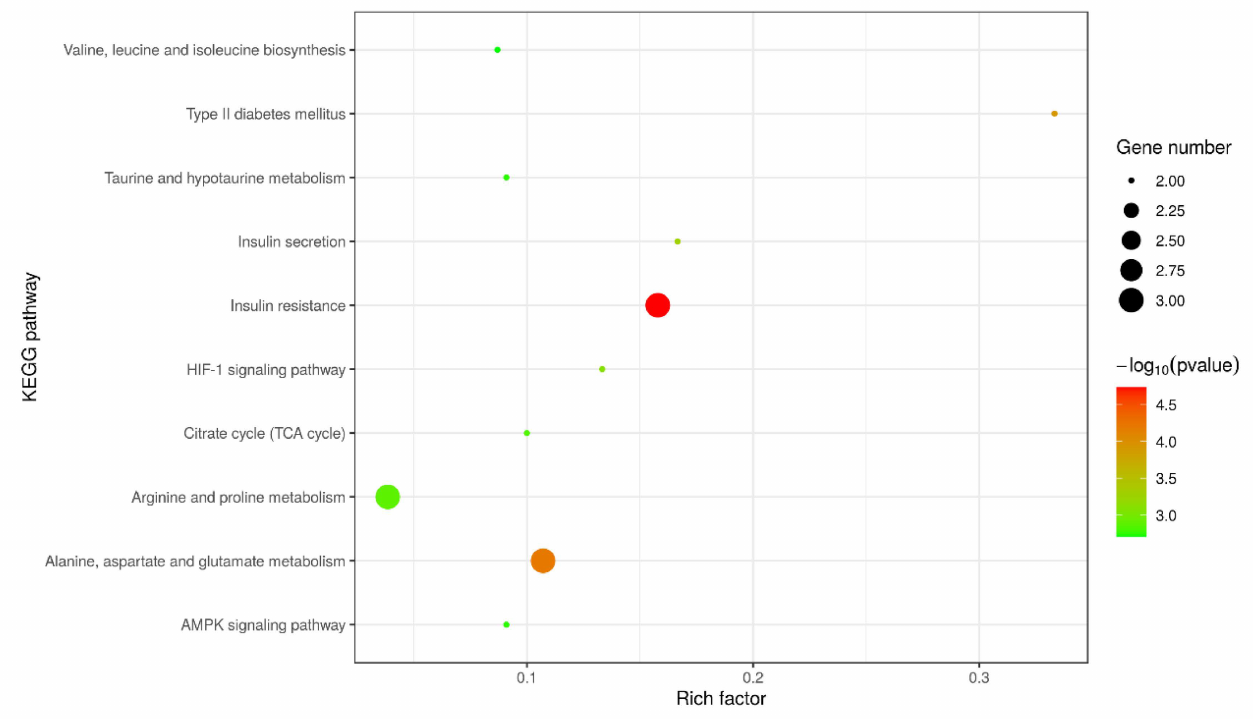
Figure 5. KEGG metabolic pathway analysis diagram of metabolites from livers of goats. Table 2. Significantly modulated metabolites in the goat liver with Cd poisoning based on